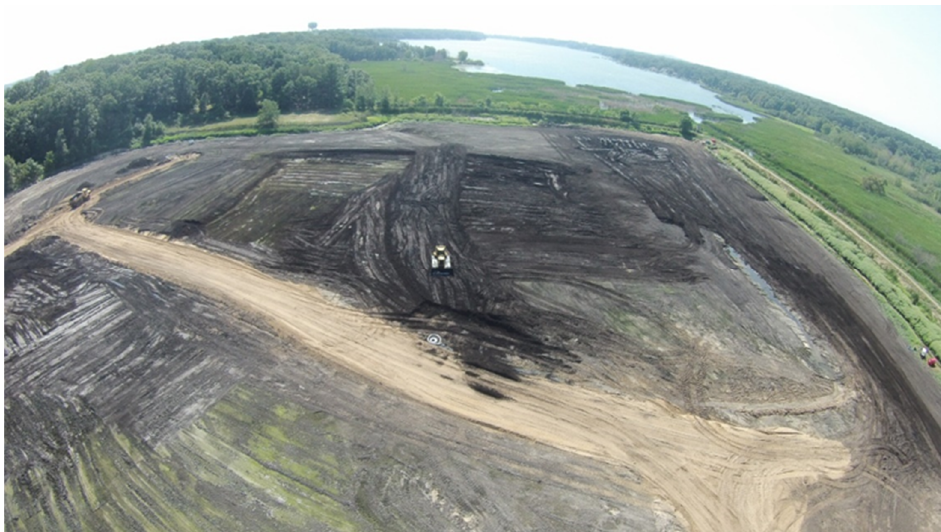
Figure 2. Aerial view of the de-watered west pond. Note Bear Lake in the background. Witham Road, which separates the west and east ponds, is located just out of the frame at the bottom of the photo. Bear Creek is located to the right, which can be traced by starting at Bear Lake and following it upstream and out of the frame halfway up the right side of the photo. Immediately to the left of Bear Creek is the grassy berm, which was removed for hydrologic connection Photo courtesy of Brian Majka, GEI Consultants.